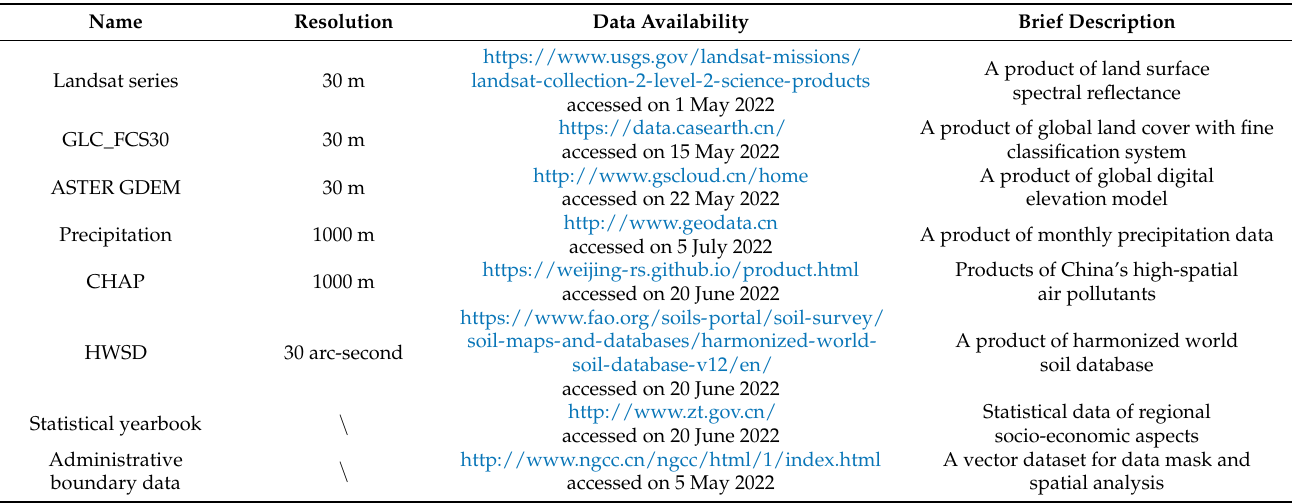
Table 1. Brief introduction of